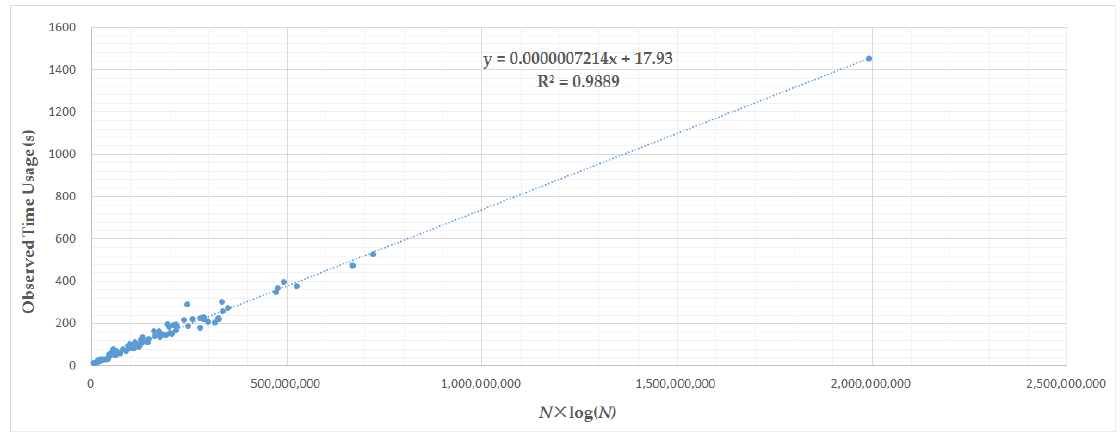
Figure 8. Linear order regression of P 3 (This is the relation between N × log ( N ) and the time usage in polygon overlay, where N is the number of vertices).